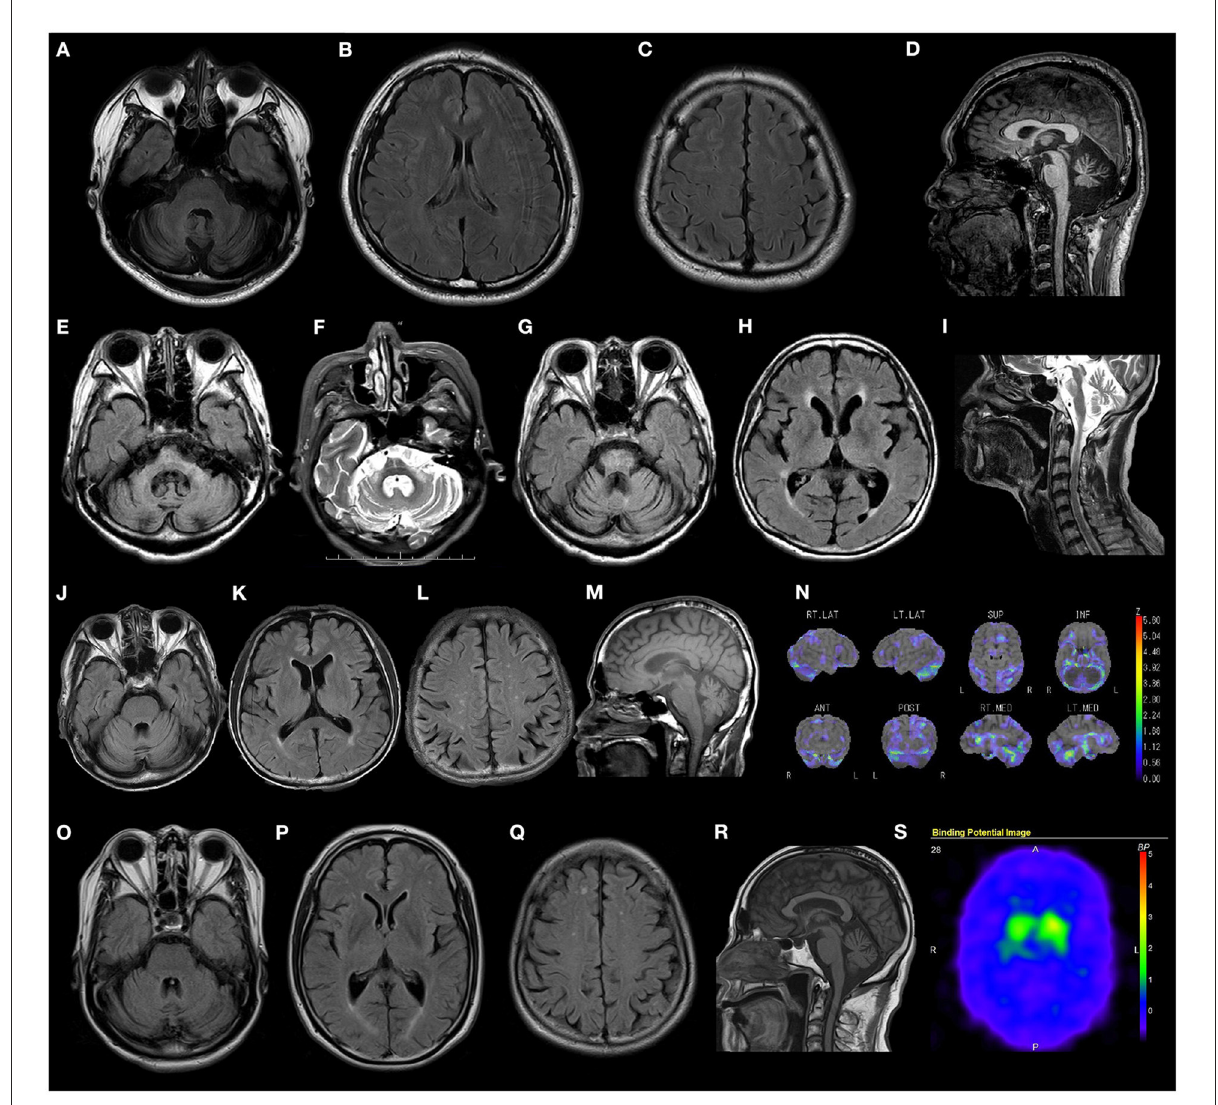
FIGURE3 Radiological findings of patients with RFC1 repeat expansions. (A–D) Brain MRI FLAIR images of patient 4 show marked cerebellar atrophy, without any atrophy in the brainstem and cerebrum. (E–I) Brain MRI FLAIR and T2 weighted images of patient 14 show marked cerebellar and brain stem atrophy, high T2 signal in the middle cerebellar peduncle, and hot cross bun sign. (J–N) Brain MRI FLAIR, T1 weighted images, and IMP-SPECT (decrease) images of patient 12 show slight cerebellar atrophy and decreased cerebellar blood flow, with no atrophy or hypoperfusion in the brainstem or cerebrum. (O–S) Brain MRI FLAIR images, T1 weighted images, and Datscan imaging of patient 15 show slight atrophy of the cerebellum and reduced striatal uptake of the dopamine